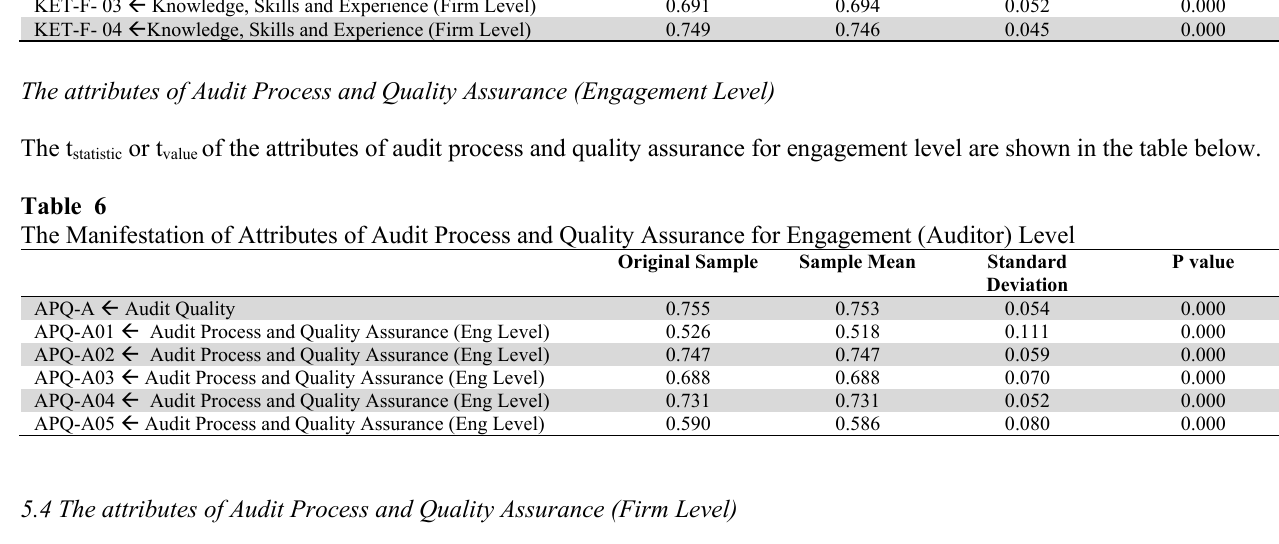
The Manifestation of Attributes of Knowledge, Skills, and Experience for Firm (Public Accounting Firm) Level KET-F  Audit Quality